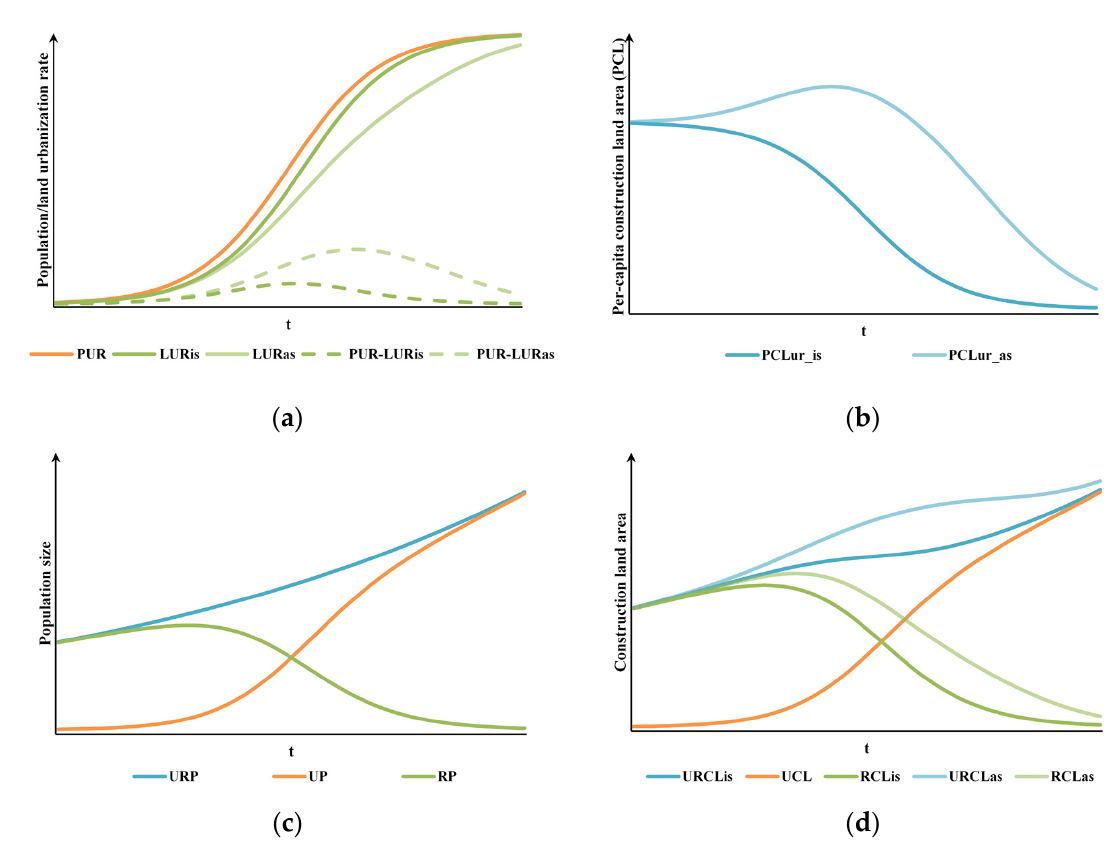
Figure 1. The transition process of urban–rural construction land (URCL) and population: ( a ) PUR is the population urbanization rate. LUR is and LUR as are the land urbanization rates in the ideal and actual situations, respectively. ( b ) PCL ur_is and PCL ur_as are the per-capita URCL areas in the ideal and actual situations, respectively. ( c ) URP, UP, and RP are the urban–rural population size, urban population size, and rural population size, respectively. ( d ) URCL is , UCL, and RCL is are the urban–rural construction land area, urban construction land area, and rural construction land area in the ideal situation, respectively. URCL as and RCL as are the urban–rural construction land area and rural construction land area in the actual situation,